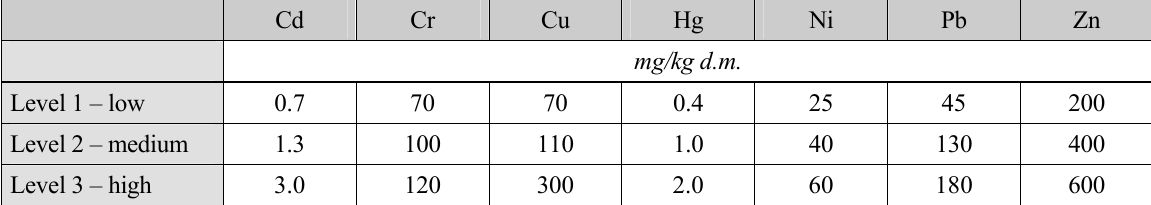
Table 18: Very strict (level 1 – low), moderate (level 2 – medium) and relaxed/soft (level 3 – high) potential limits for heavy metals used in this study for the evaluation of the impact of limit setting on compost production, marketing and use Cd Cr Cu Hg Ni Pb Zn mg/kg d.m. 0.7 70 70